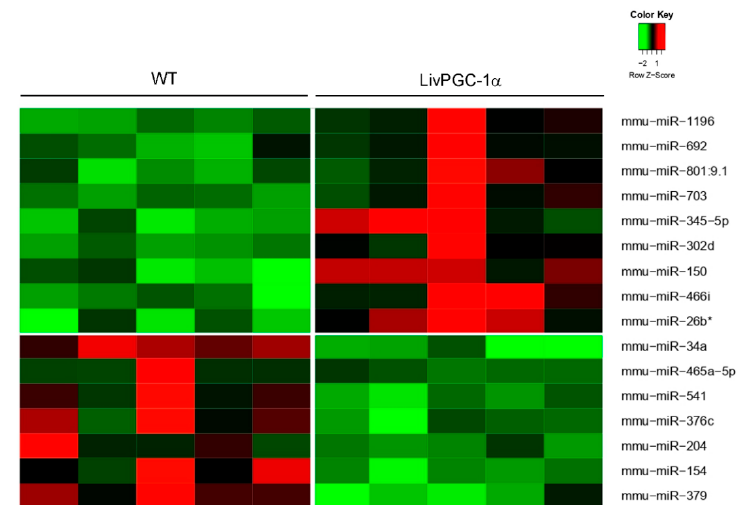
Figure 1. Microarray analysis of hepatic microRNAs in mice overexpressing proliferator-activated receptor (PPAR)- γ coactivator alpha (PGC-1 α ) in the liver compare to wild type control. The data are shown in a heatmap with a matrix format; each single row represents the expression of one microRNA in a single liver sample harvested from overnight fasted LivPGC-1 α mice or WT controls (column). To visualize the results, the expression levels of each gene are represented by a color (red: expression greater than the mean; black: expression equal to the mean; green: expression smaller than the mean). The * is used to distinguish mature microRNA that, differently from the dominant-highly expressed microRNA, originates from the opposite arm of the hairpin precursor.